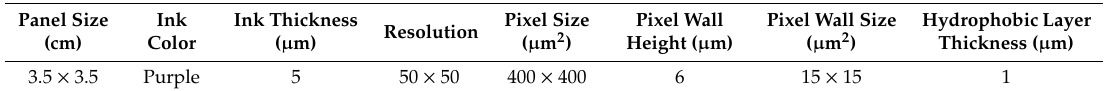
Table 2. Parameters of the EWD